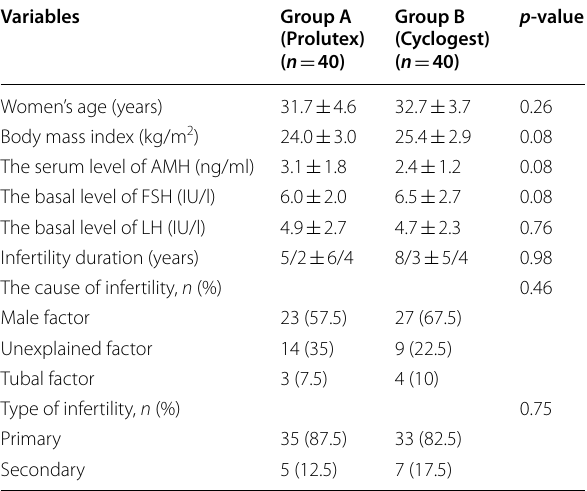
Table 2 Comparison of the ovarian stimulation outcomes between two groups